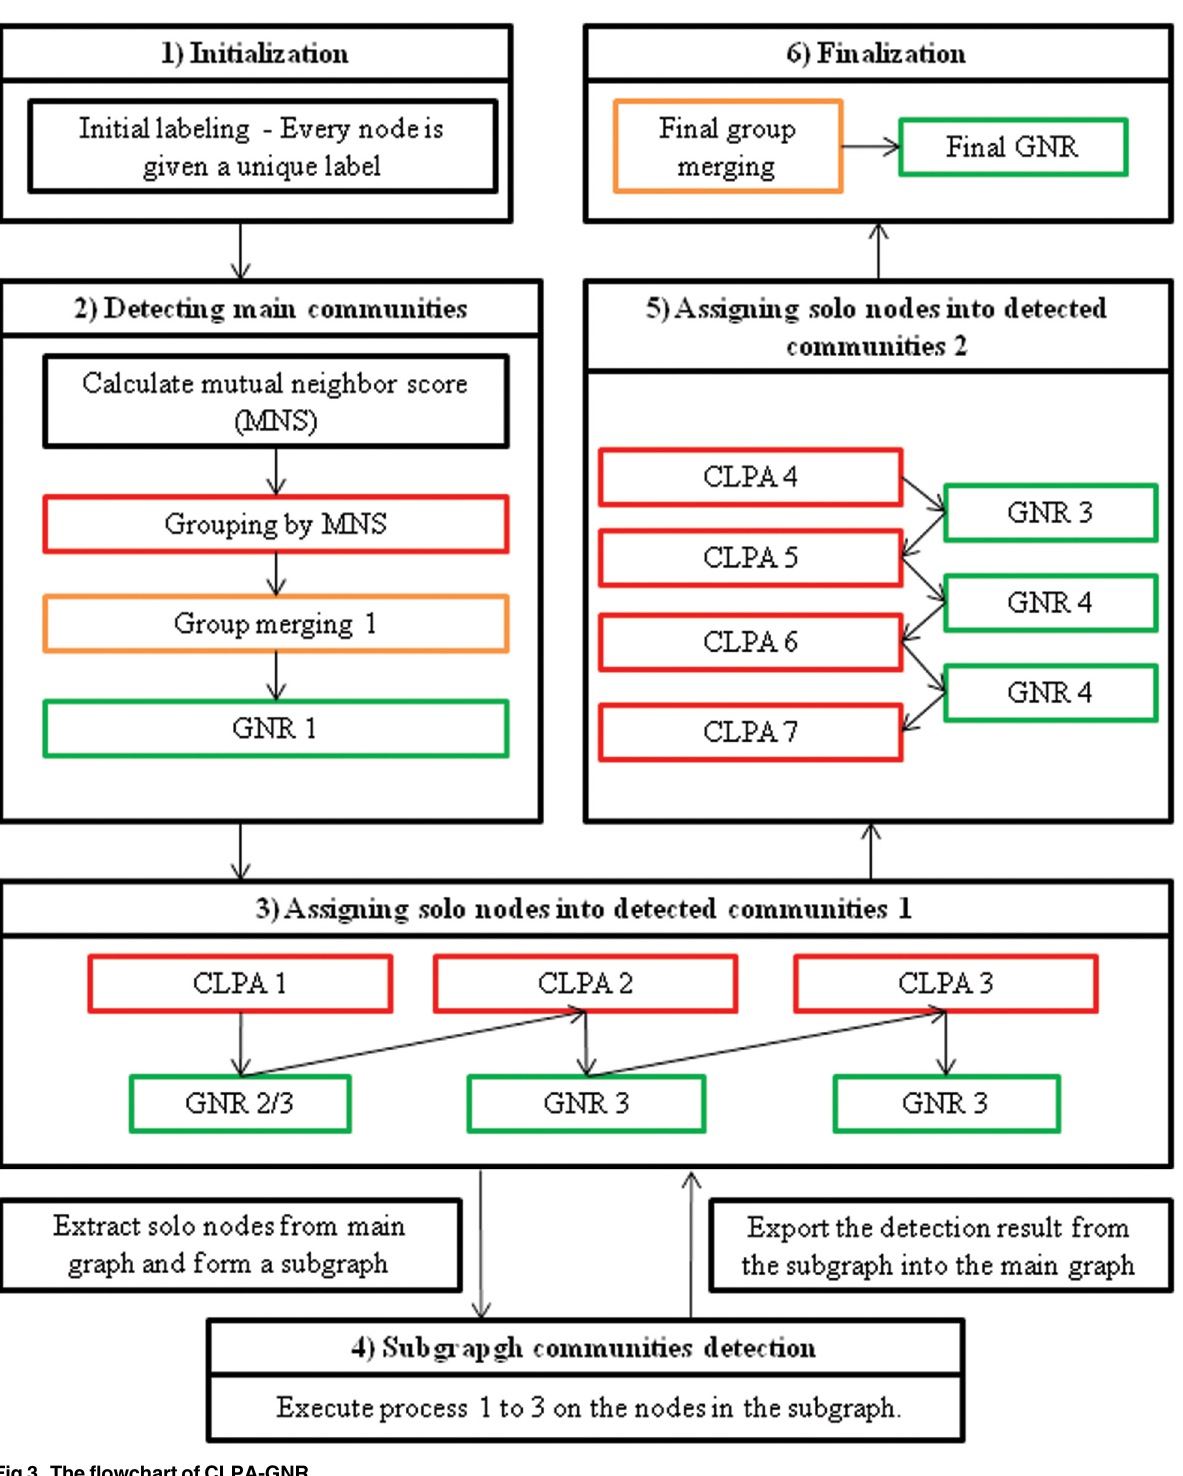
Fig 3. The flowchart of